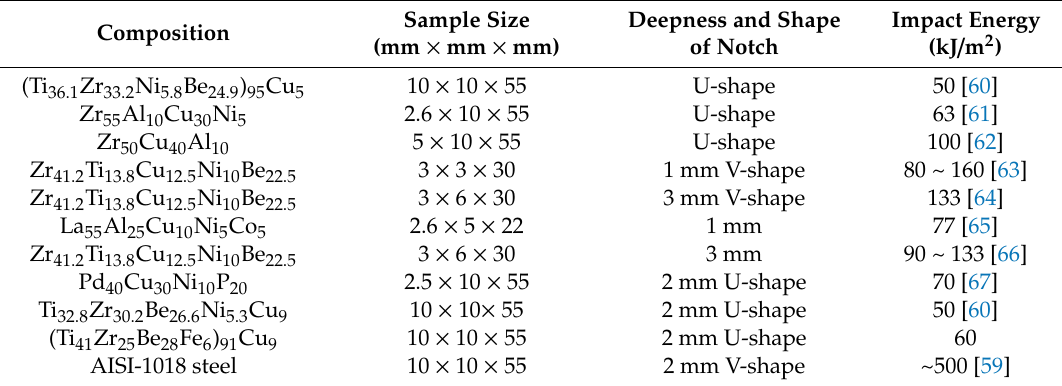
Table 1. Impact toughness data of di ff erent metallic glasses.